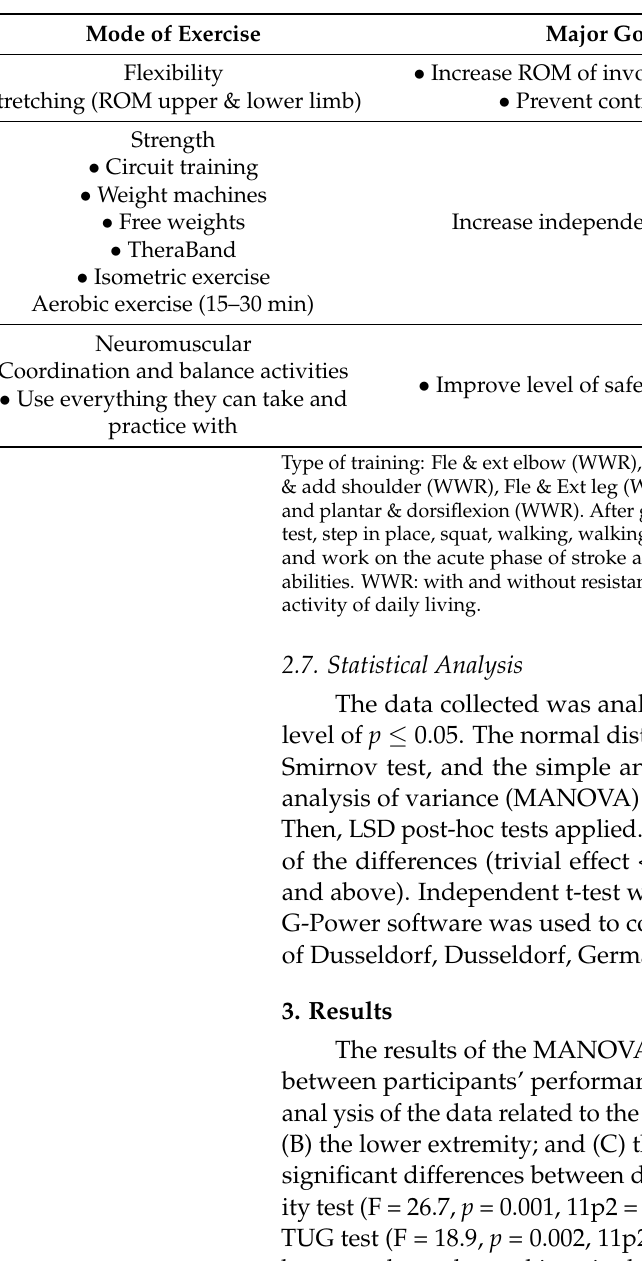
Table 2. Neuromuscular rehabilitation